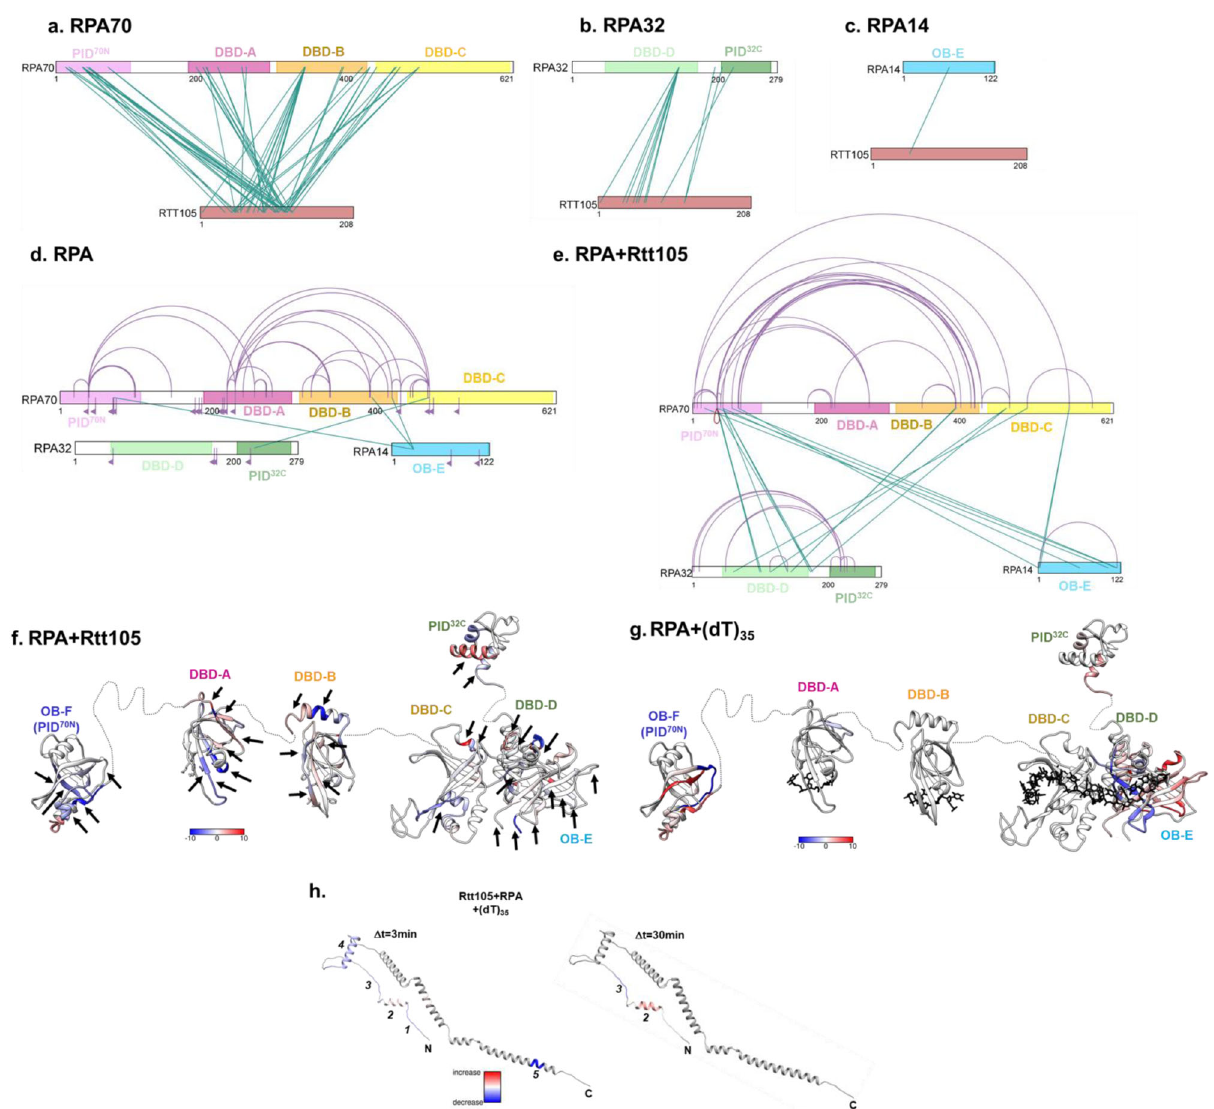
Fig. 4 | Rtt105 con fi gurationally staples RPA through multiple contacts with DBDs and PIDs. Crosslinking mass spectrometry (XL-MS) analysis of the RPA- Rtt105 complex reveals crosslinks between Rtt105 and a RPA70, b RPA32, and c RPA14 subunits. Crosslinks are observed in all OB-folds and the BC-linker. Inter- subunit (green lines) and intra-subunit (purple traces) crosslinks in RPA are shown inthe d absenceor e presenceofRtt105,respectively.Anincreaseinbothinter-and intra-subunitcrosslinksareobserveduponRtt105bindingtoRPA.Theinverted fl ag marksin d denote the sitesof mono-crosslinksand showthattheyhavenopartner sites available in proximity for the BS3 crosslinker due to the extended